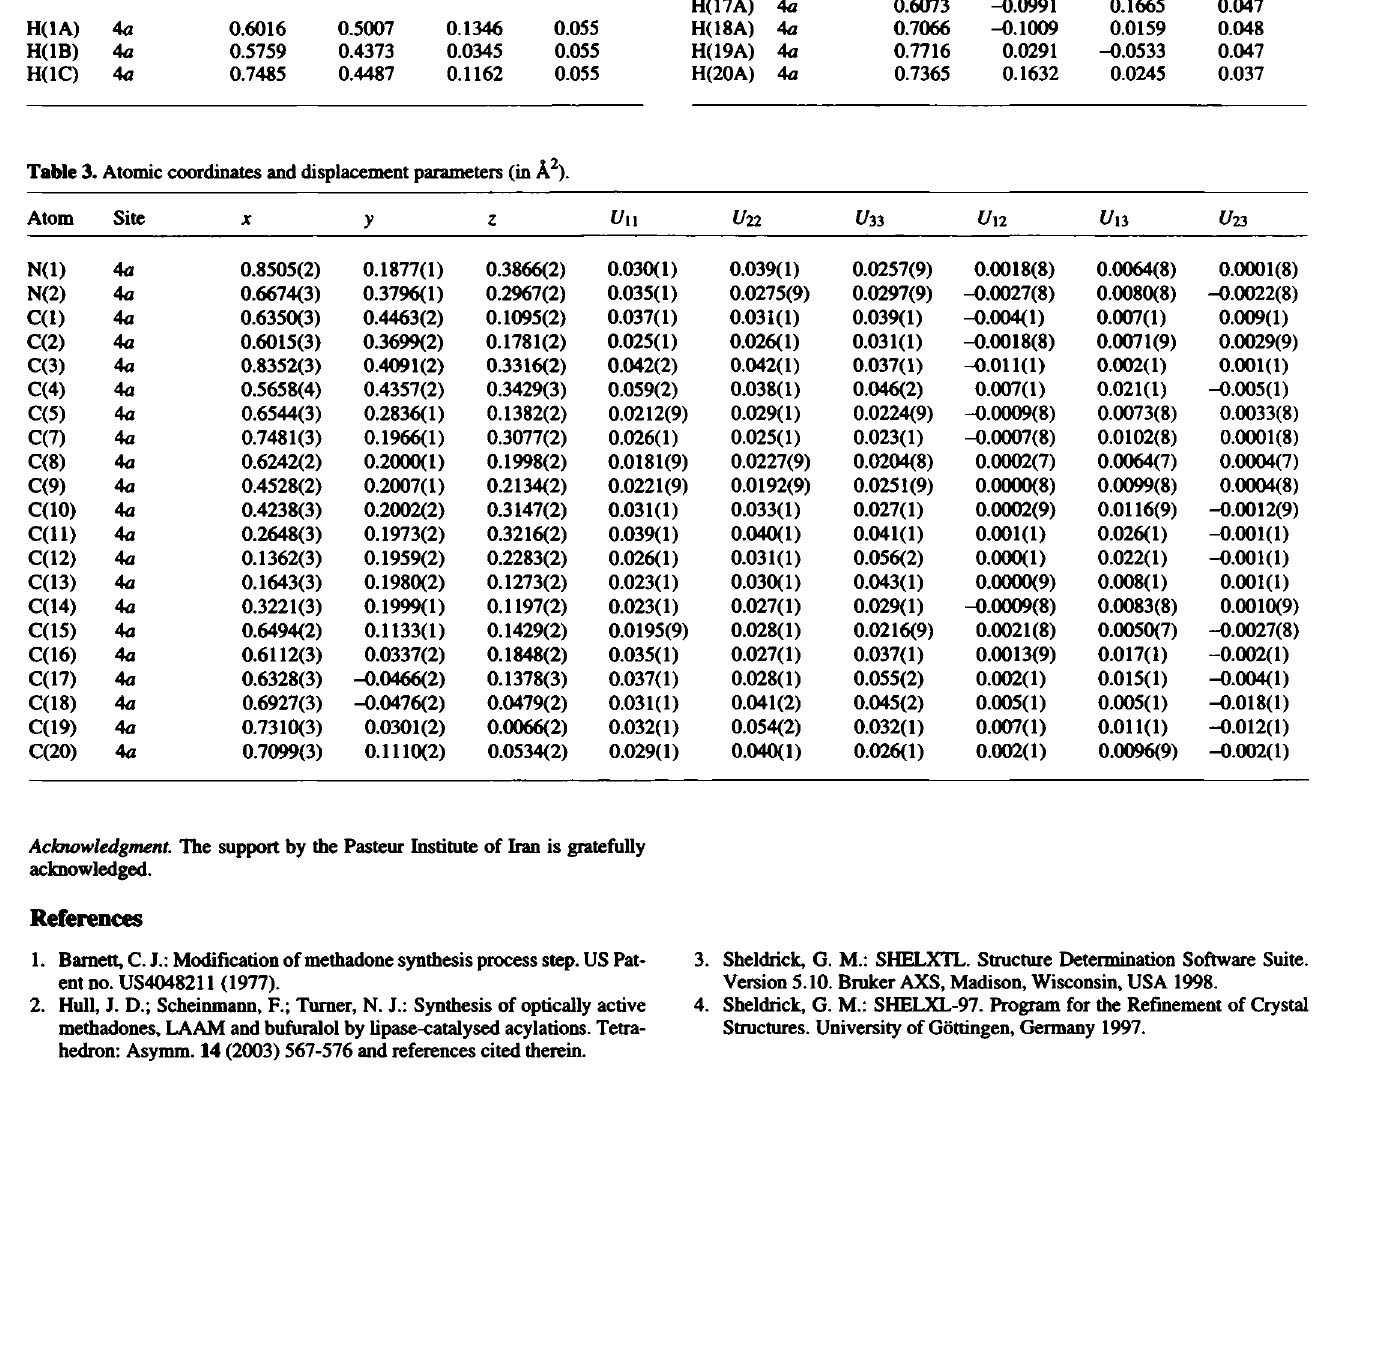
Table 3. Atomic coordinates and displacement parameters (in Ä 2